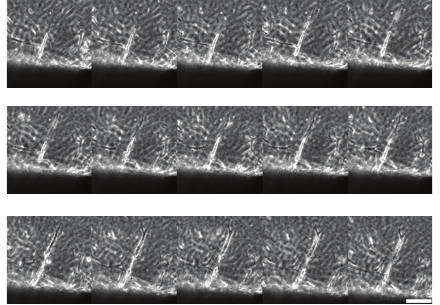
Figure 2: Time-lapse imaging of additional sprouts emerging and extending in a sequential manner from the leading edges of a newly formed capillary tube from the mouse aortic explant. Selected sequence from a time-lapse movie focusing on a single sprout. Note the protrusion of lamellipodia and continued migration of the lead- ing cell. Scale bar = 50 𝜇 m.